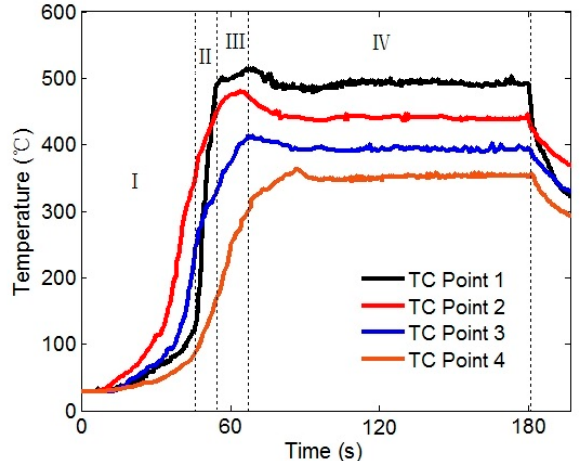
Figure 6. Temperature test results of the welding area (900 rpm spindle speed and 100 mm/min welding speed).